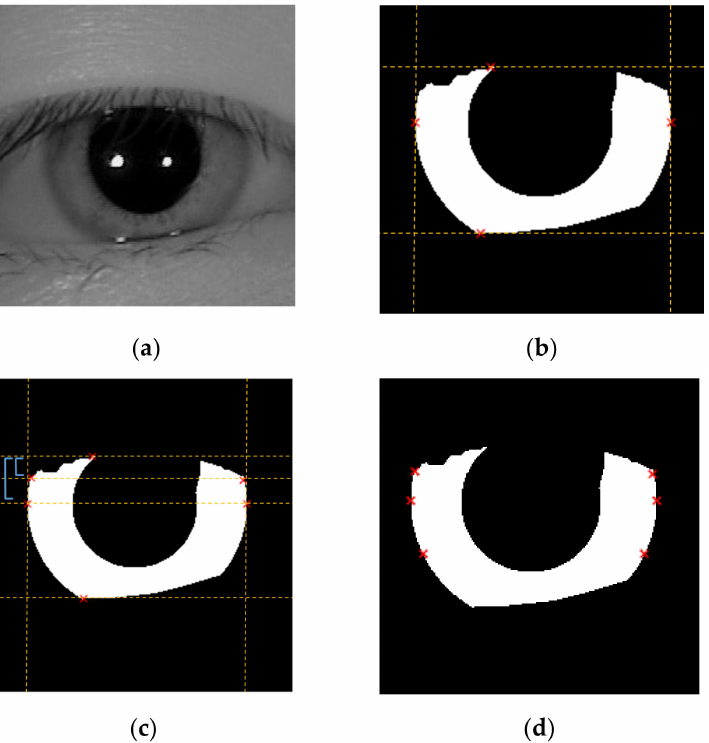
Figure 7. A pictorial example to show how to recover six saliency points for estimating inner boundary. ( a ) The iris image whose upper part is occluded by the eyelid; ( b ) the iris mask ROI (derived from the proposed IRUNet) and the left-most, right-most, top-most, and bottom-most endpoints of ROI; ( c ) the two saliency points on the upper part of ROI is derived by finding the intersection between the ROI and the scan line, which has equal distance to the top-most and left-most endpoint; ( d ) the six saliency points recovered by the proposed method. After that, all the points will be connected to other corresponding points so that several line segments, which go across the pupil can be formed. We perform a diagonal connection between two saliency points in order to make sure that the line passes through the pupil region, rather than goes horizontally. From those lines, we can get the saliency points for inner boundary by looking for the intersection between the diagonal lines and the pupil mask. To locate the circle of inner boundary accurately, we did the same thing as outer boundary estimation by recovering the pupillary circle parameter using Equation (2). The whole procedure is shown in Figure